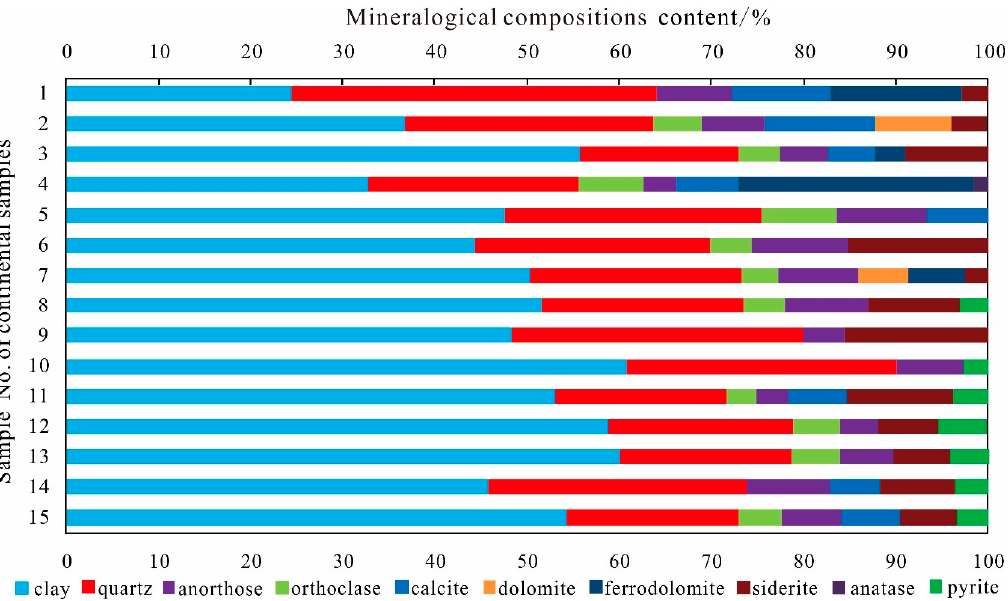
Figure 2. Mineral constituents of the studied Yanchang shale samples.